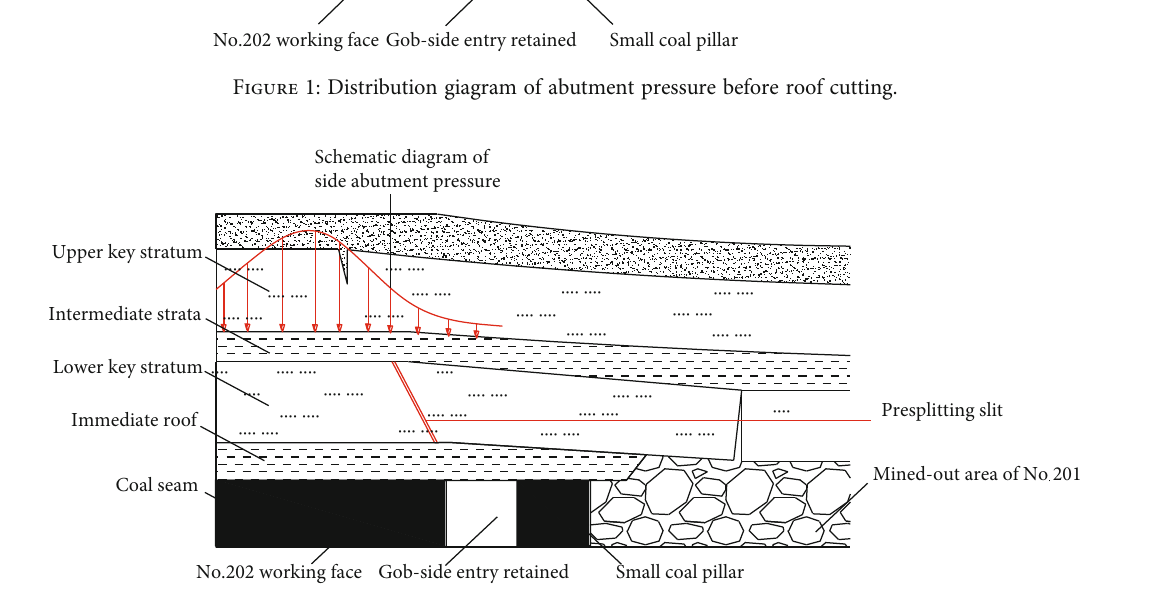
Figure 2: Distribution giagram of abutment pressure after roof cutting. Table 1: Illustrative table of support sections of the gob-side entry